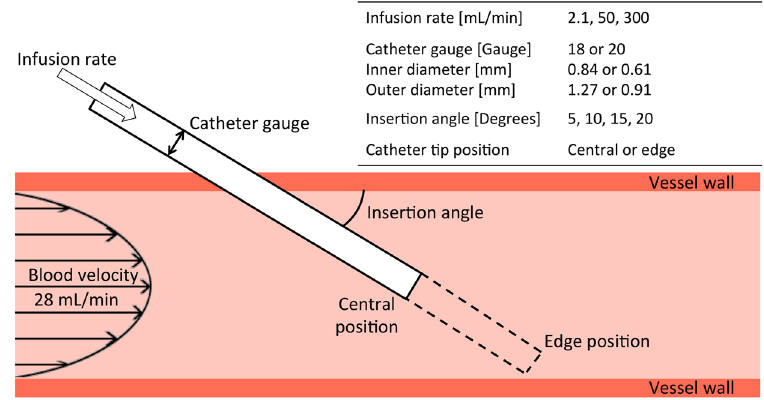
Figure 7. Illustration of parameters investigated.